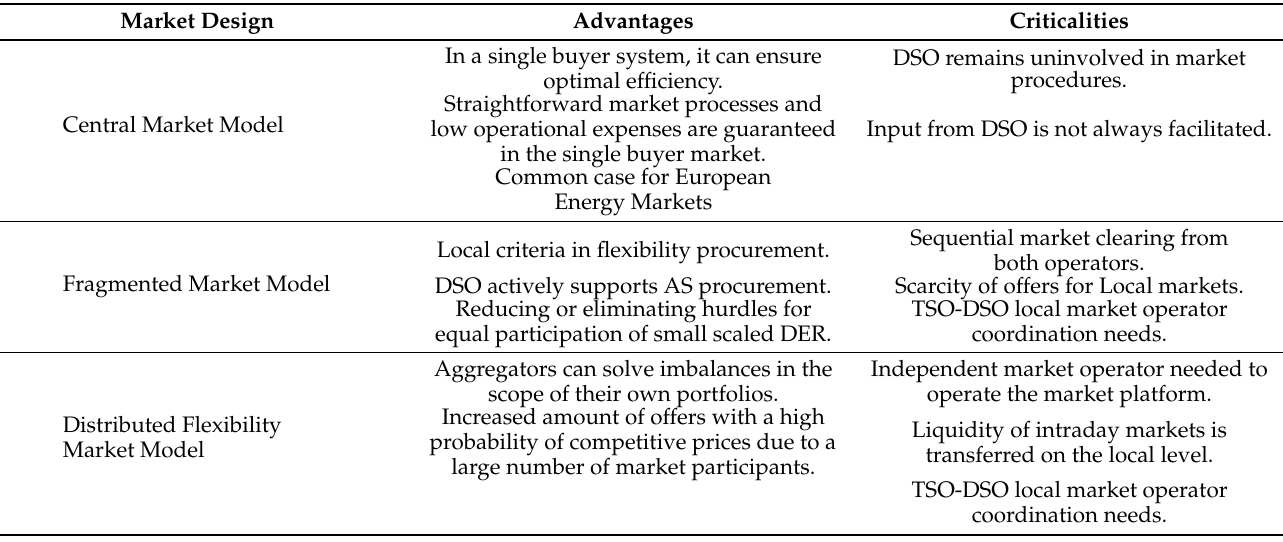
Table 1. Disjointed Market Designs for a Voltage Control Market as identified in European Re- search